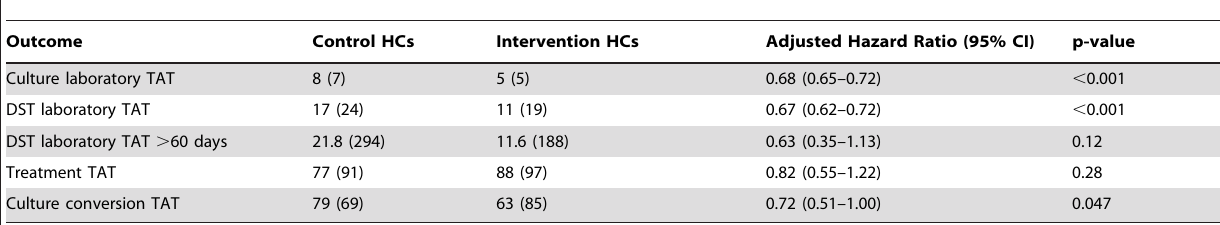
Table 3. Primary and secondary